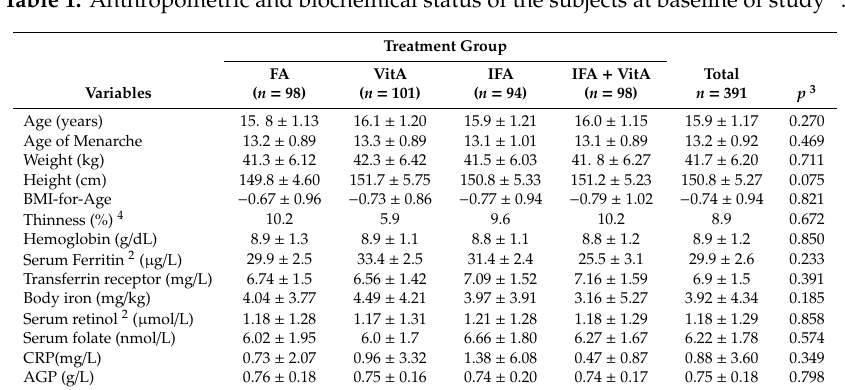
Table 1. Anthropometric and biochemical status of the subjects at baseline of study 1